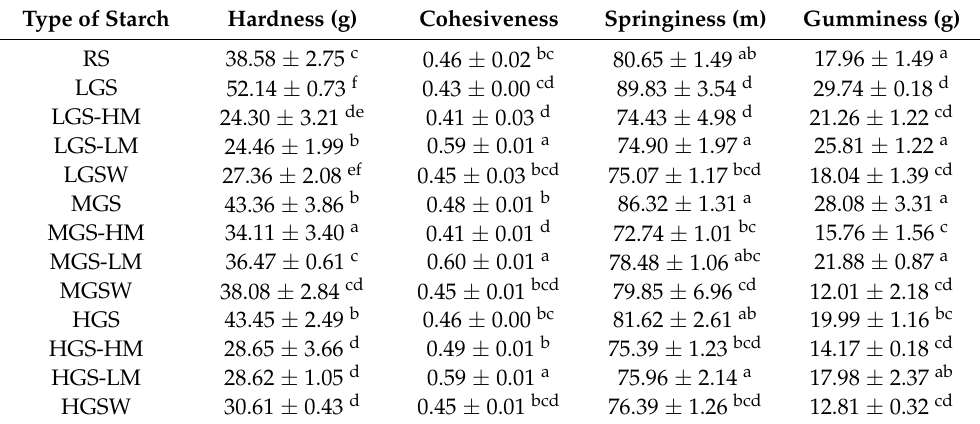
Table 5. Texture properties of starch pastes with different DSG reheated by different